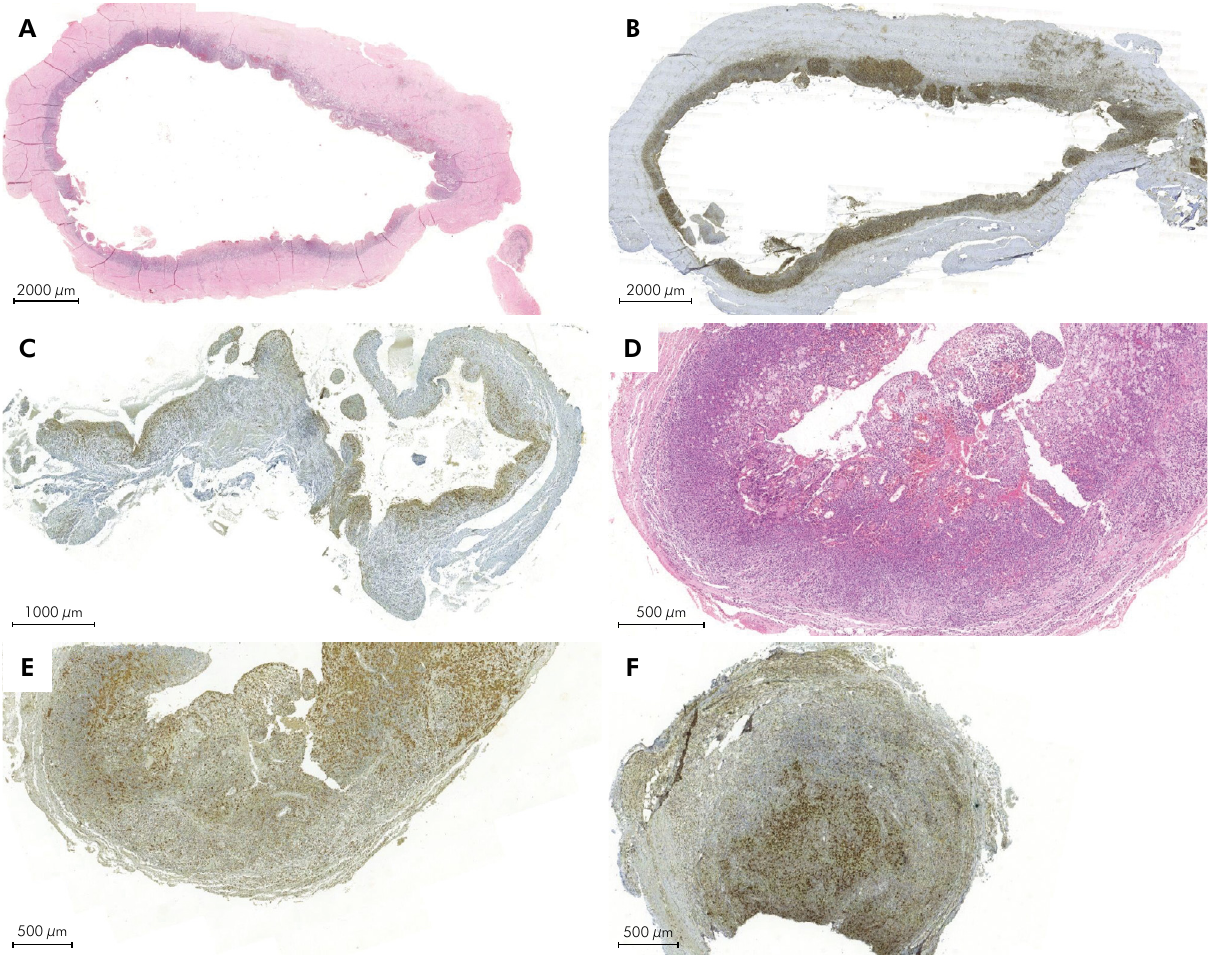
Figure 1. (A) Hematoxylin and eosin immunostaining of RCs (Scale bar: 2000 μ m); (B and C) Intense inflammation and subepithelial immunostaining areas in RCs (Scale bar: 2000 μ m, 1000 μ m); (D) Hematoxylin and eosin immunostaining of PGs (Scale bar: 500 μ m); (E. F) Middle region PG immunostaining (Scale bar: 500 μ